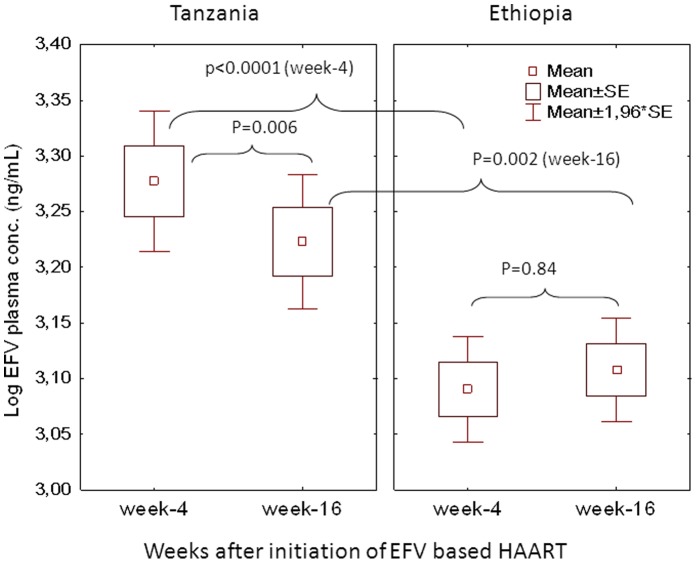
Comparison of mean ± SE of mean efavirenz plasma concentration on the 4th and 16th weeks after initiation of efavirenz based HAART separately between Ethiopian and Tanzanian patients using independent t test.Comparison of efavirenz concentration between week 4 and week 16 with in Ethiopians and Tanzanian patients was done using paired t test. Boxes indicate mean ± SE of the mean; bars indicate mean ±1.96 × SE of the mean.